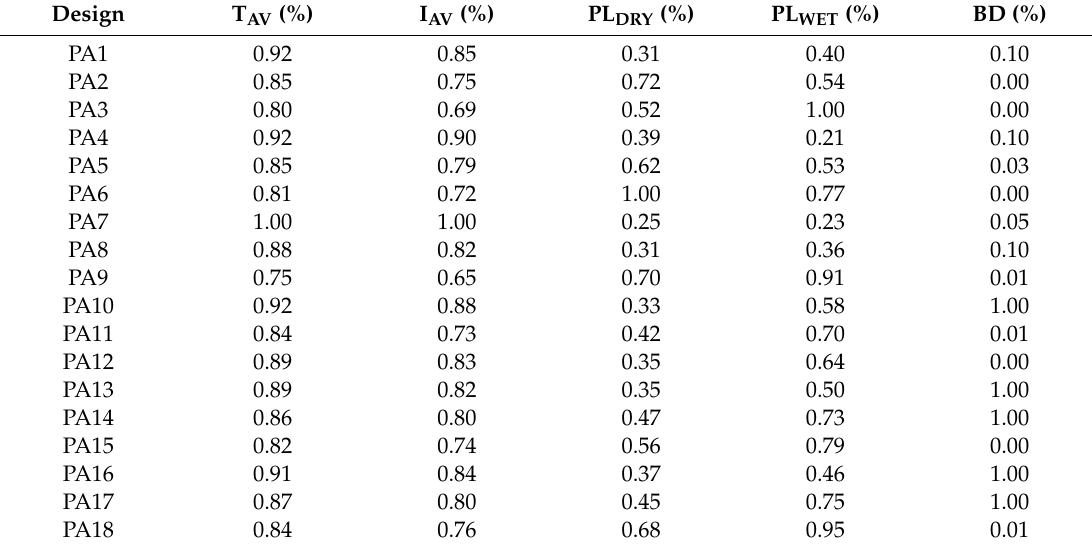
Table 10. Normalized decision matrix according to weighted aggregated sum product assessment (WASPAS) methodology.